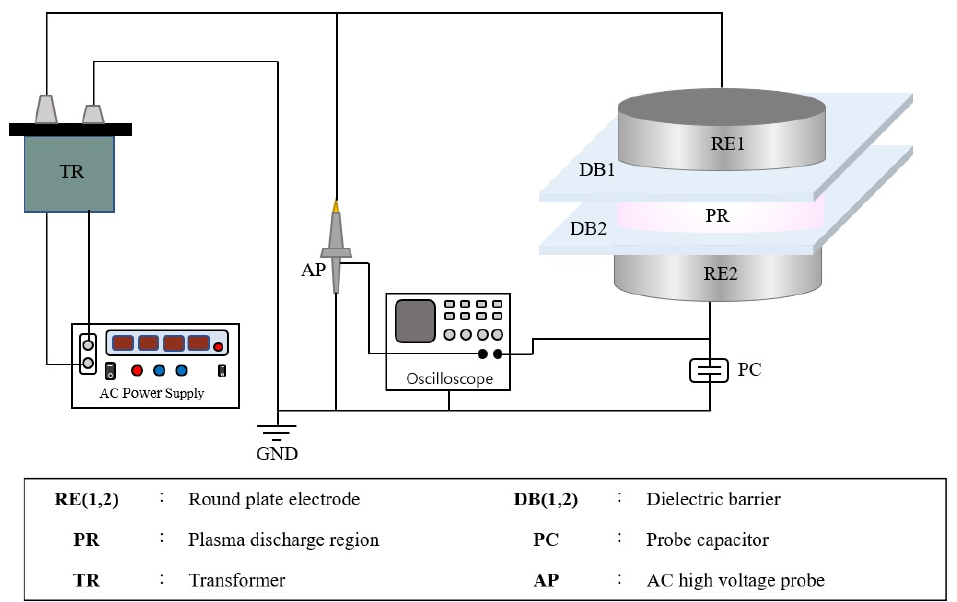
Figure 1. Schematic of the experimental setup.